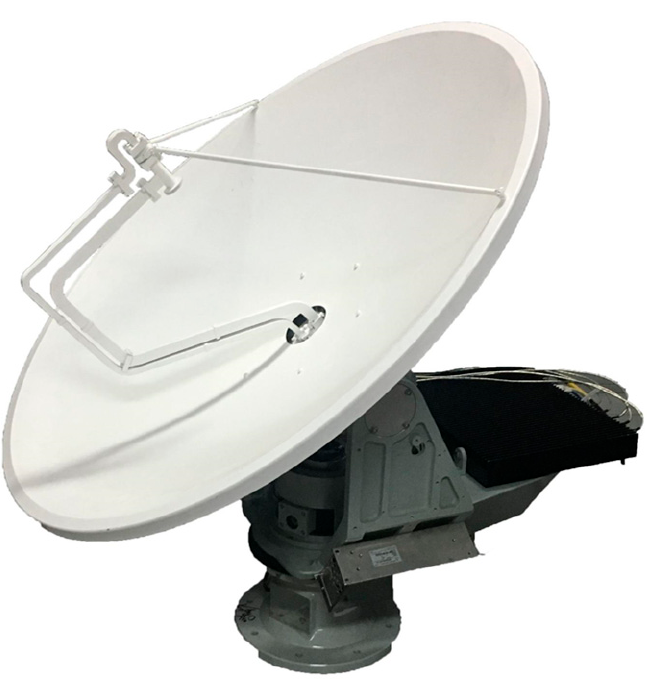
Figure 10. Ku-band entomological radar